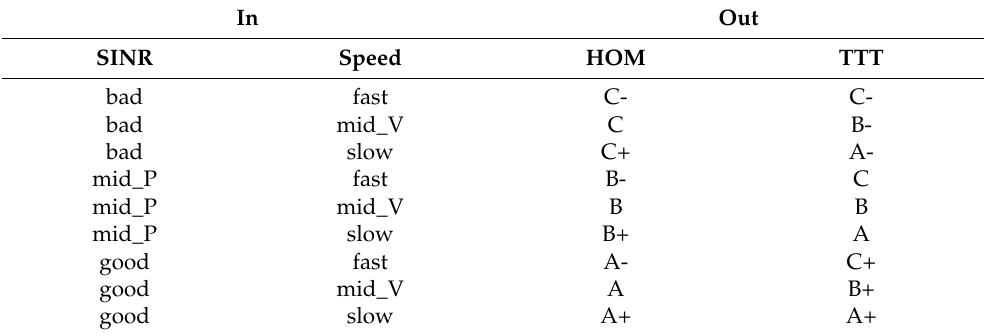
Table 3. Rule base of inference engine.